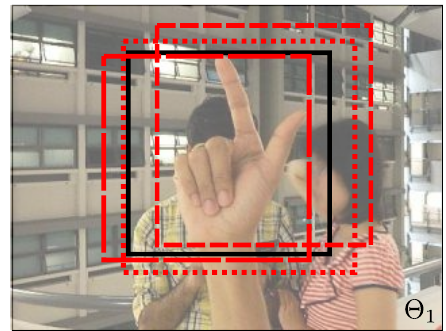
Figure 6. Positive sample generation. At the center of the image, we have the BB gt , and the dashed windows are the positive sampled BB . We generate samples by perturbing the position and the size of the BB gt using Gaussian